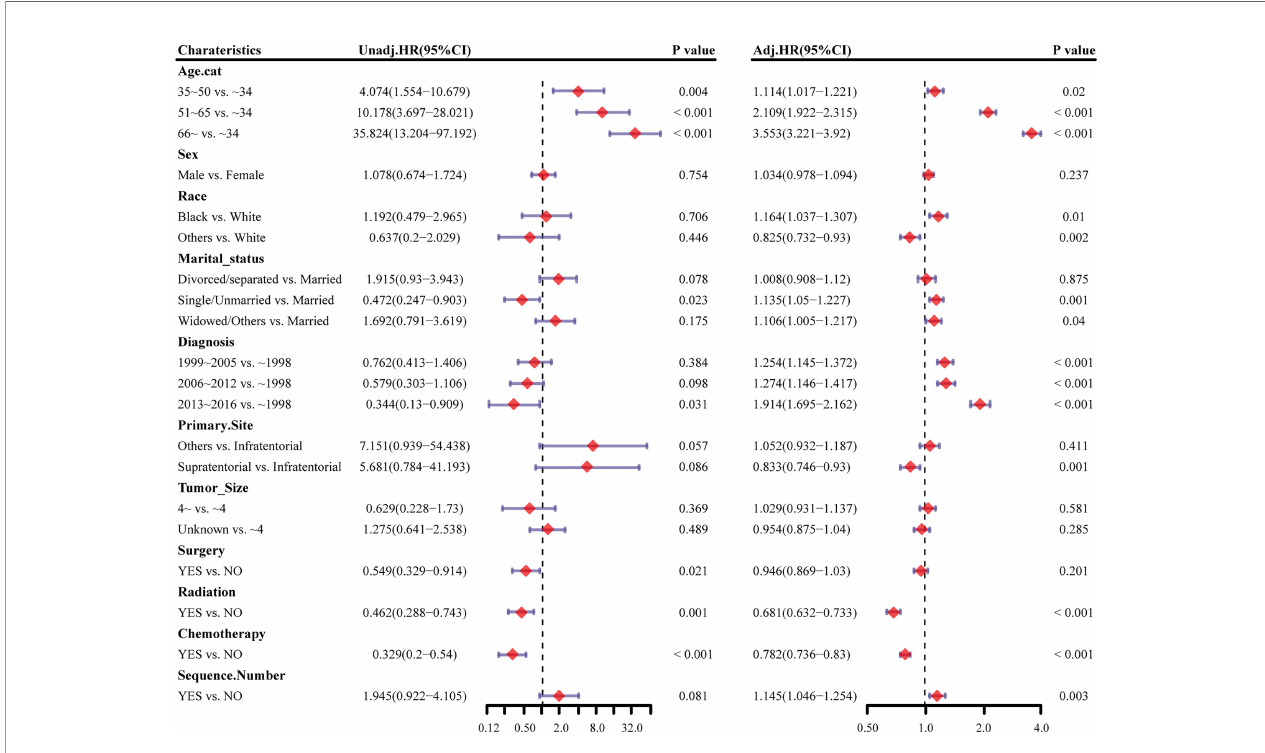
FIGURE 2 | Forest plots showing different results of (left) univariable and (right) multivariable analysis for heart disease – related mortality based on the Cox proportional hazards model. HR, hazard ratio; CI, con fi dence